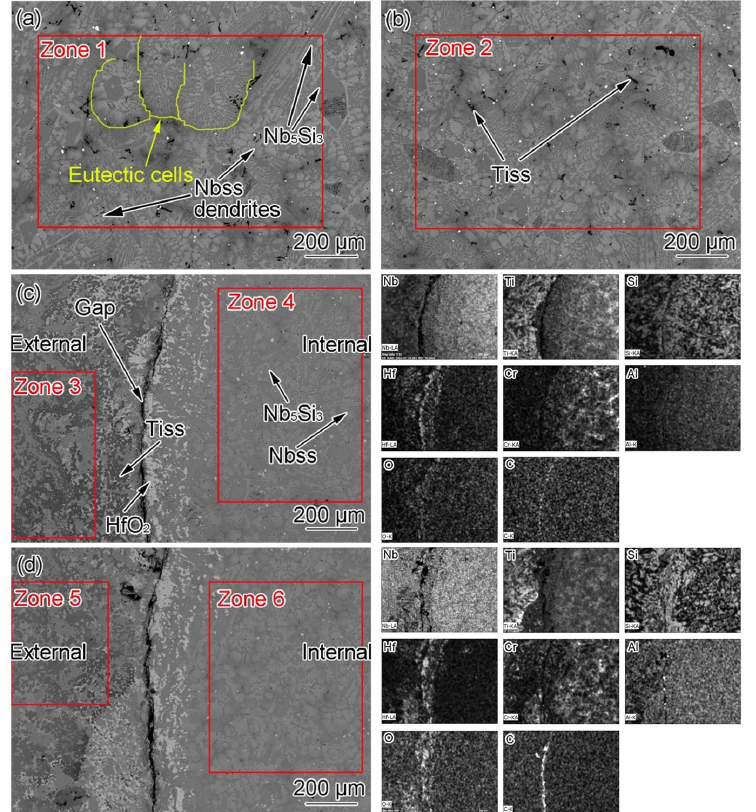
Figure 7. BSE images of the Nb–Si-based alloy re-melted in: ( a ) Y and ( b ) Z mold shells in a vacuum furnace with a tungsten heating element and ( c ) Y and ( d ) Z mold shells in a vacuum furnace with a graphite heating element.